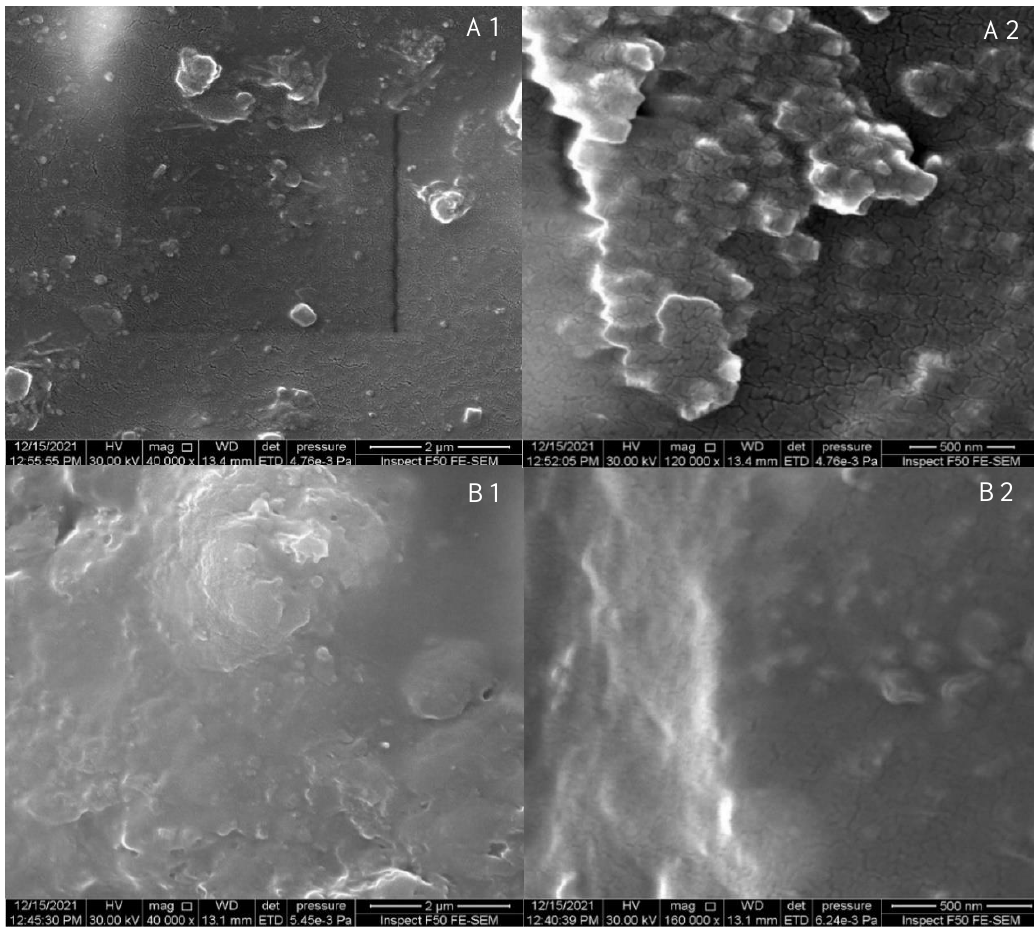
Figure 2: SEM morphological images of sawdust/epoxy nanocomposites with (A1 & A2) 1 vol.% of ZnONPs and (B1 & B2) 0.5 vol.% of